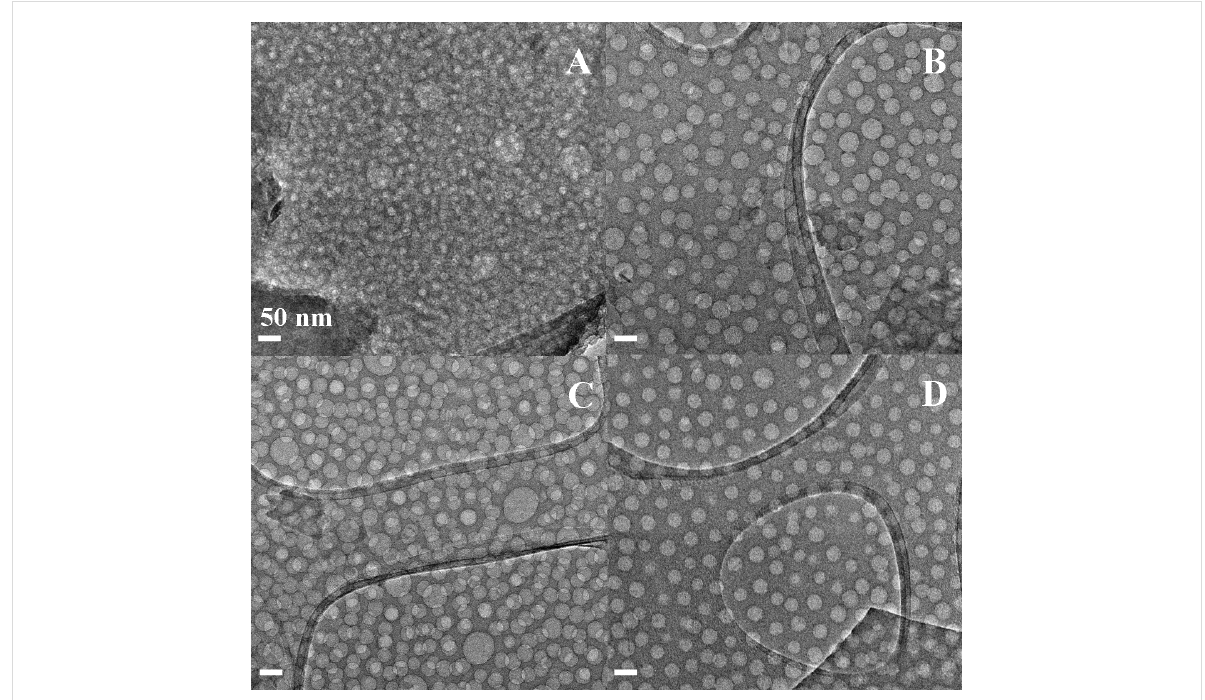
Figure 1: HRTEM micrographs of calcined 95TEOS/5PS- b -PEO films obtained by using different block copolymers, namely: PS 117 - b -PEO 543 (A), PS